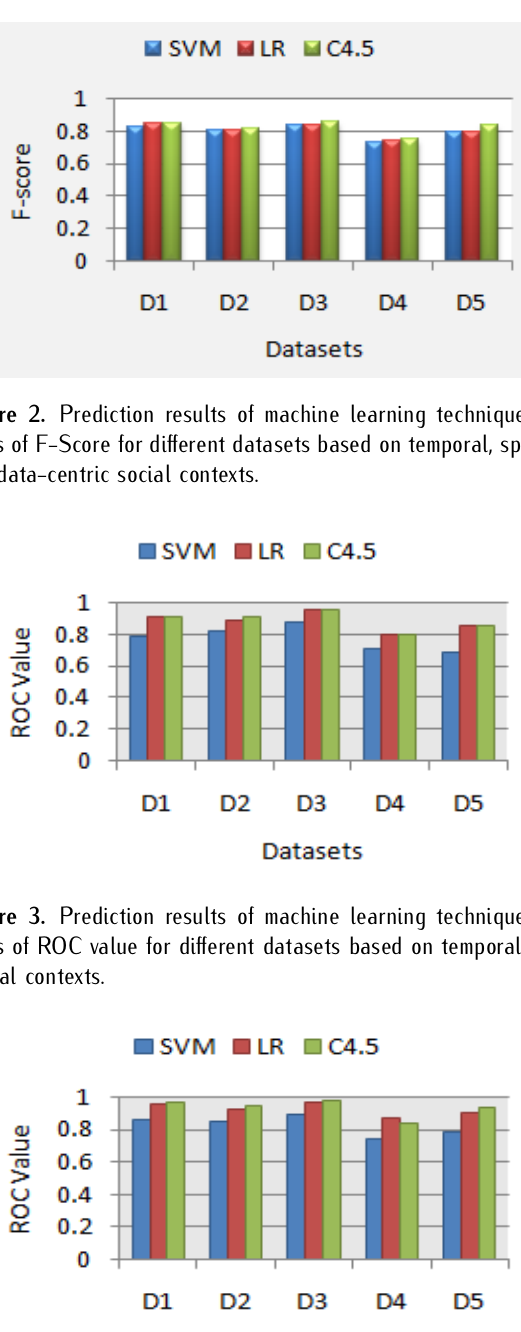
to build an e ff ective prediction model using machine learning techniques for the purpose of developing relevant contact-specific real-life mobile applications for the benefit of end